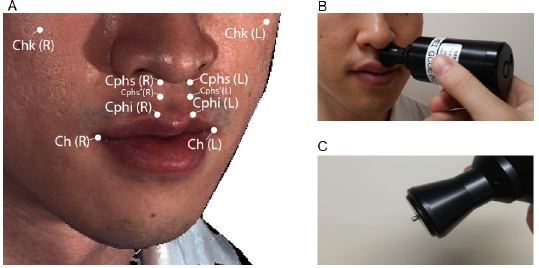
Fig 1. Landmarks used for the measurement of viscoelasticity in the present study (A), measurement of viscoelasticity in the facial soft tissue with a viscoelasticity measuring instrument (B), and the indenter of the viscoelasticity measuring instrument (C). Chk, cheek; Cphs, crista philtri superior, Cphs’, the point on the philtral crest approximately 12 mm below the Cphs (newly defined); Cphi, crista philtri inferior; Ch, cheilion; L, cleft side; R, right side. Black arrow in (B): probe of the viscoelasticity measuring instrument (Vesmeter-E100Hs; WaveCyber Corp., Saitama, Japan). Black arrow in (C): indenter of the viscoelasticity measuring instrument.